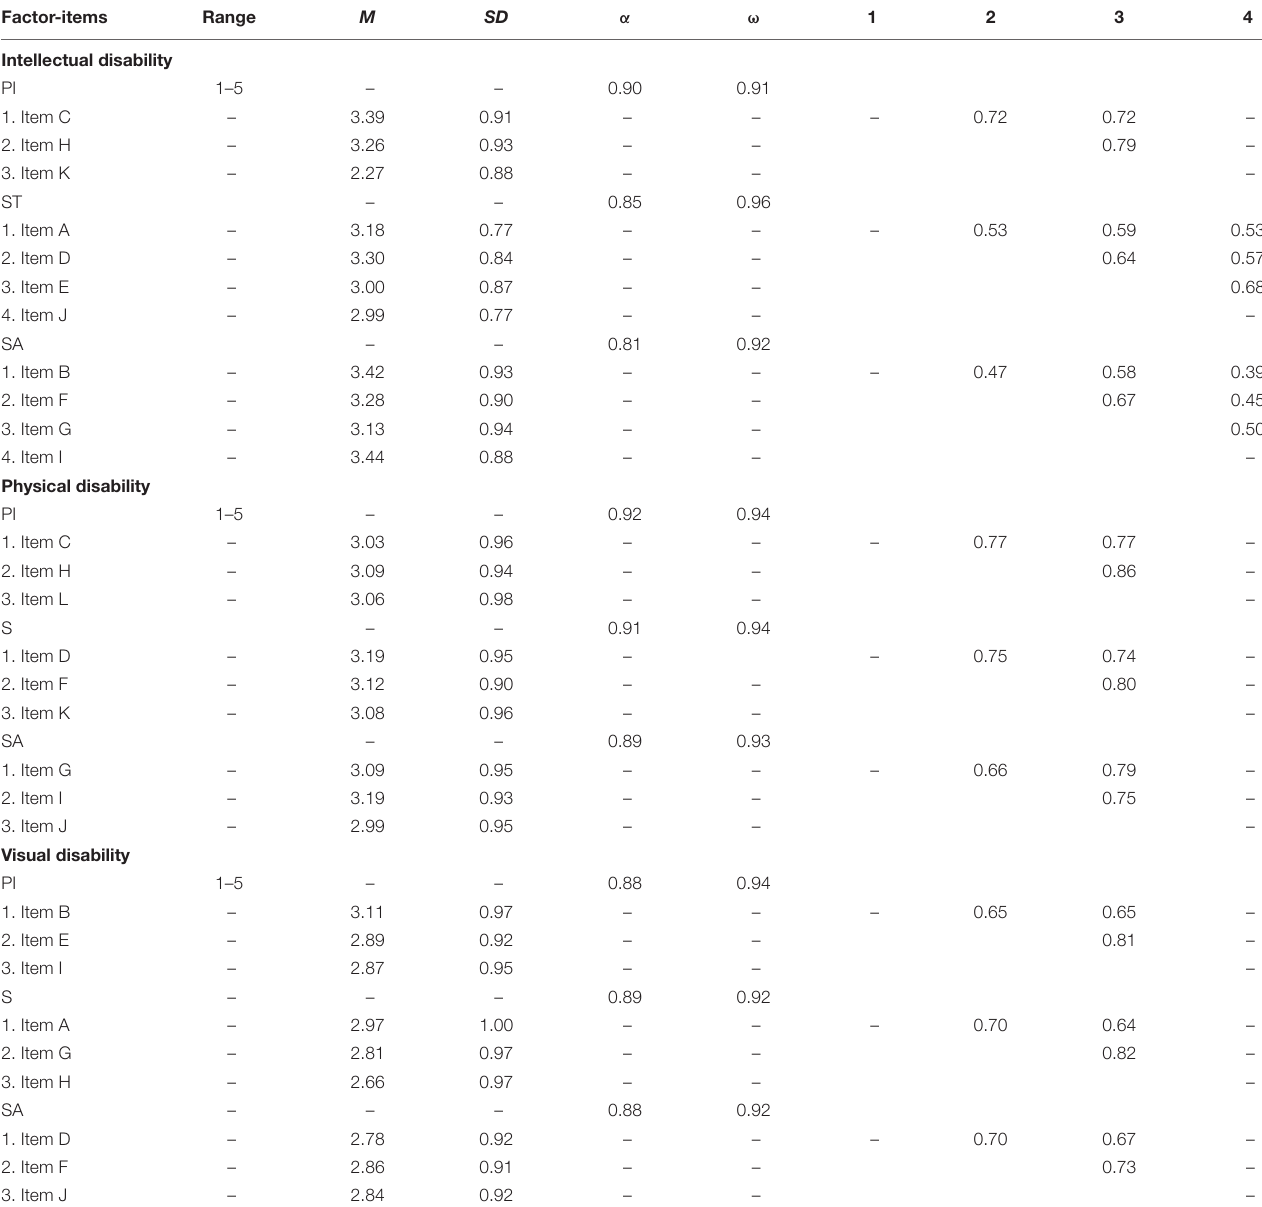
TABLE 2 | Range, descriptive statistics, cronbach alpha, omega index, and Pearson’s correlations of all the items of the subescales. Factor-items